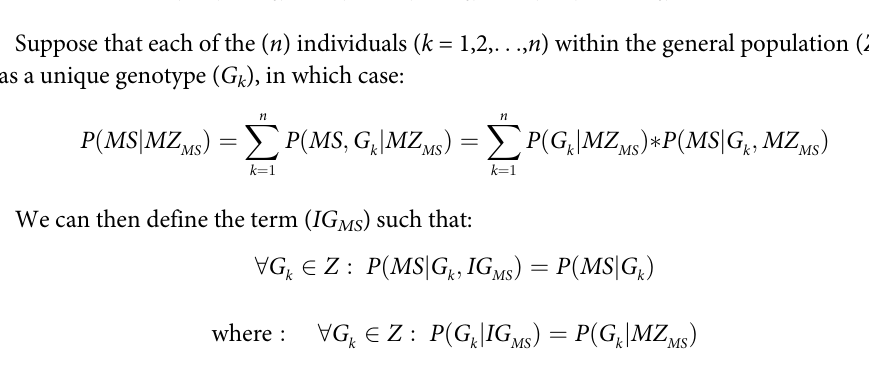
Table 3. Canadian population data on MZ -twin concordance broken down by ( H+ )-haplotype and gender-status � . MZ-Twins HLA-DRB1 � 15 Status H+ H– Totals Concordant for MS (C) 9 11 20 Discordant for MS (D) 31 42 40 53 93 0.23 0.21 0.22 Proband-wise Concordance 0.31 0.29 0.30 Gender Status Totals Concordant for MS (C) 22 2 24 Discordant for MS (D) 66 43 109 88 45 133 0.25 0.04 0.18 0.34